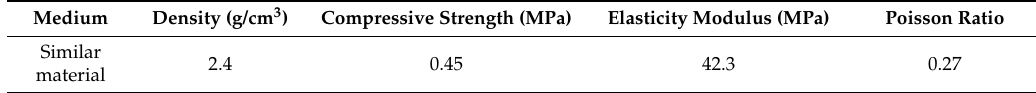
Table 2. Similar material physical and mechanical parameters.